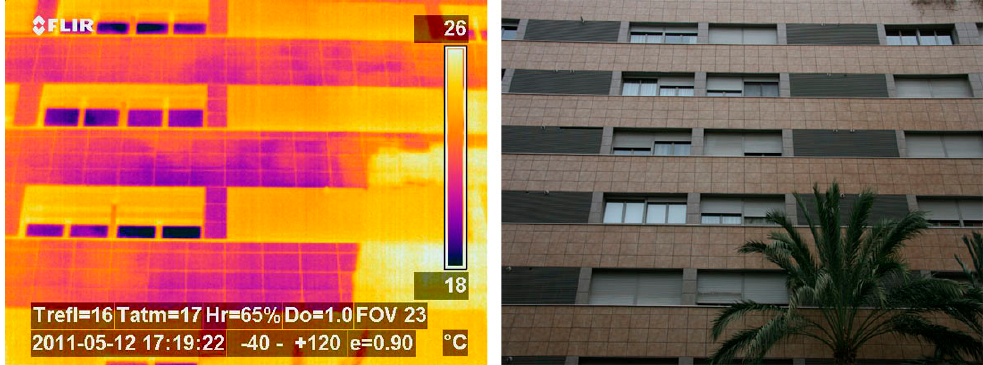
Scheme 1. Graph of metric study of thermal flow showing the temperature and flow data from which the U-value was calculated. Table 6. Results of U-values across different scenarios.